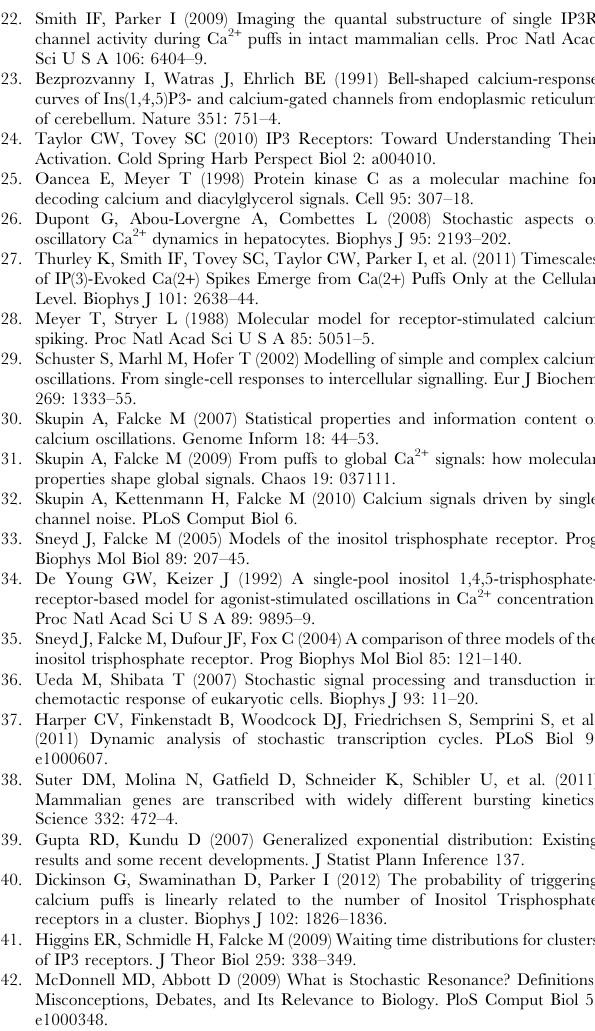
Figure S1 Comparison of the generic model with the exact analytic results provided by the hierarchic sto- chastic model. Shown are the results for the realistic channel closing rate c (black lines) and two examples with lower time scale separation. (A) The approximation error grows linear with the average number of failed puffs, given by 1 = C 14 . (B) The relative approximation error is smaller than 10% for the realistic closing rate. Table S1 Parameter values for the De Young-Keizer model. The De Young-Keizer model with the parameters in this table is used to compute the opening transition times y o . Table S2 Analytical approximation of the GE distribu- tion parameters. The values in this table result from